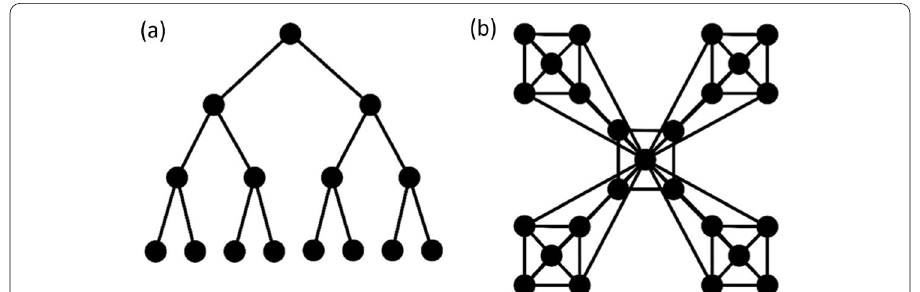
Fig. 1 a A connected tree network of seven nodes. This vulnerability of the tree graph can be seen if we consider the graph with the top most node removed; resulting in the graph fragmenting into two components. b A hierarchical community network, with each of the communities connected to the central node in the inner community (Ravasz and Barabasi,